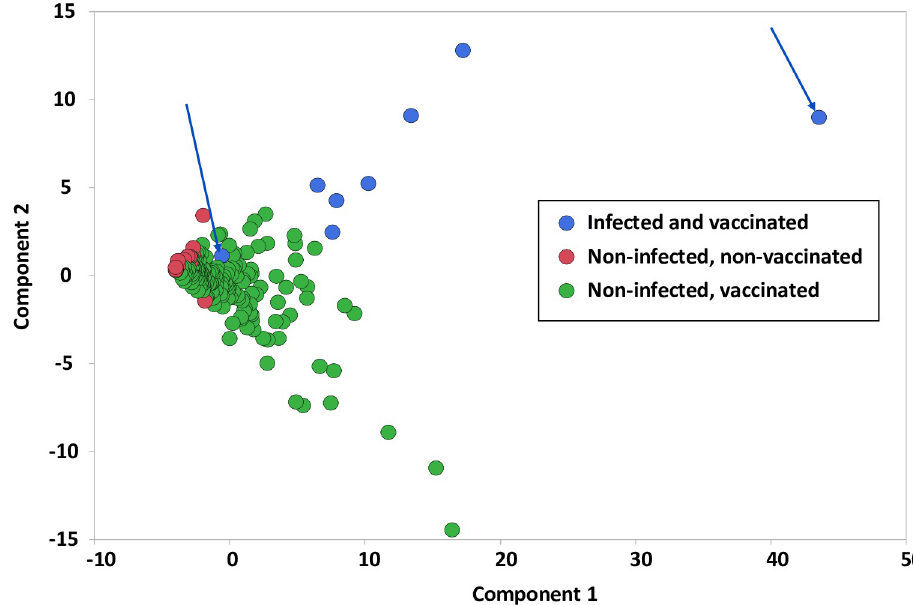
Fig 5. Scatter plot comparison of all subjects. Component 1 and Component 2 values appear to differentiate participants based on prior infection and vaccination. Participants who were infected and vaccinated had higher Component 2 values reflecting responses to the N and M proteins; however, there are two outlier subjects (blue arrows). In contrast, uninfected and vaccinated participants had lower Component 2 values reflecting the responses to the S protein. Participants who were uninfected and unvaccinated are distinct and cluster around 0.